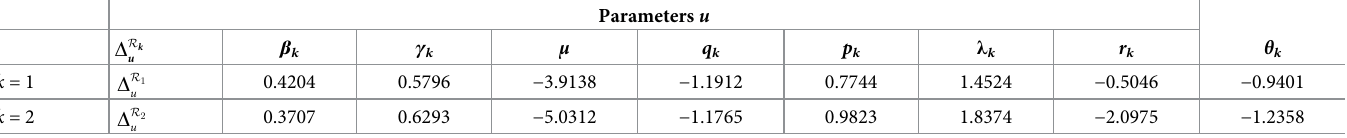
to parameters generated in Table 5 for model k